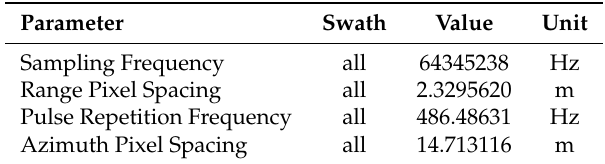
Table 3. Sentinel-1A/B parameters of the focused burst images sequence.